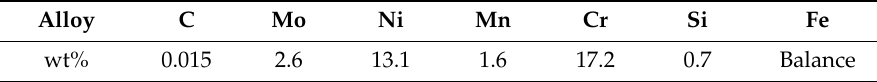
Table 3. Chemical composition of the metallic powder—316L Stainless Steel.